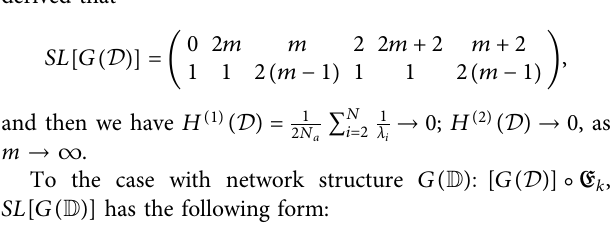
i.e., D (cid:1) K m,m × P 2 . As shown in Figure 4 , the black nodes form into a duplex structure, in which each layer is the complete bipartite graph.